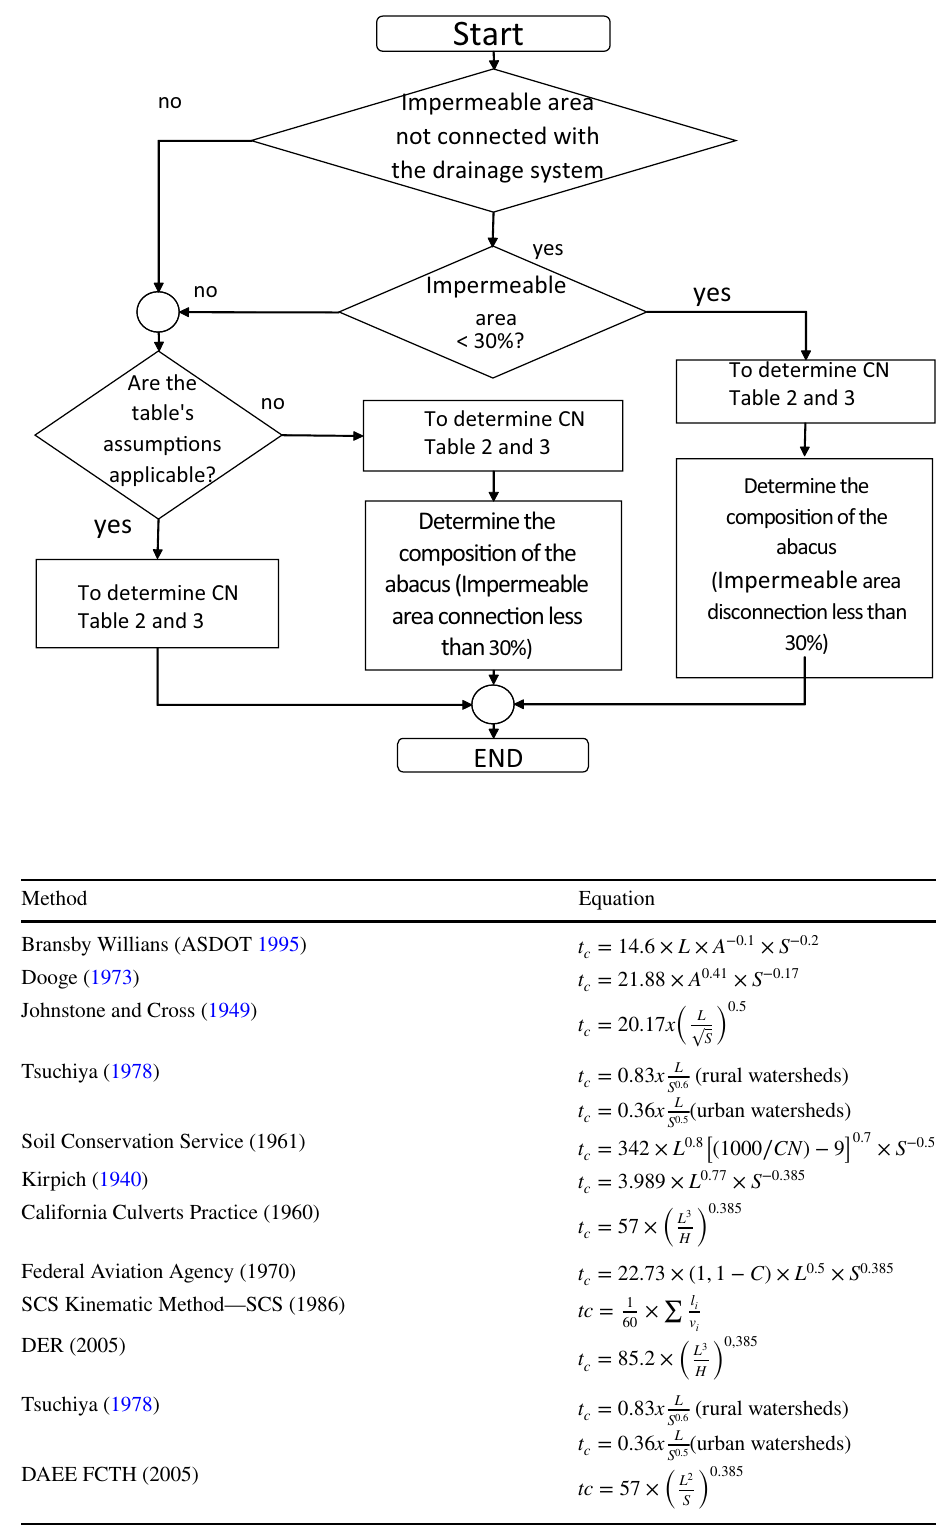
Fig. 2 CN calculation method according to impermeable area and connection to the drainage system. Adapted from USDA (1986)